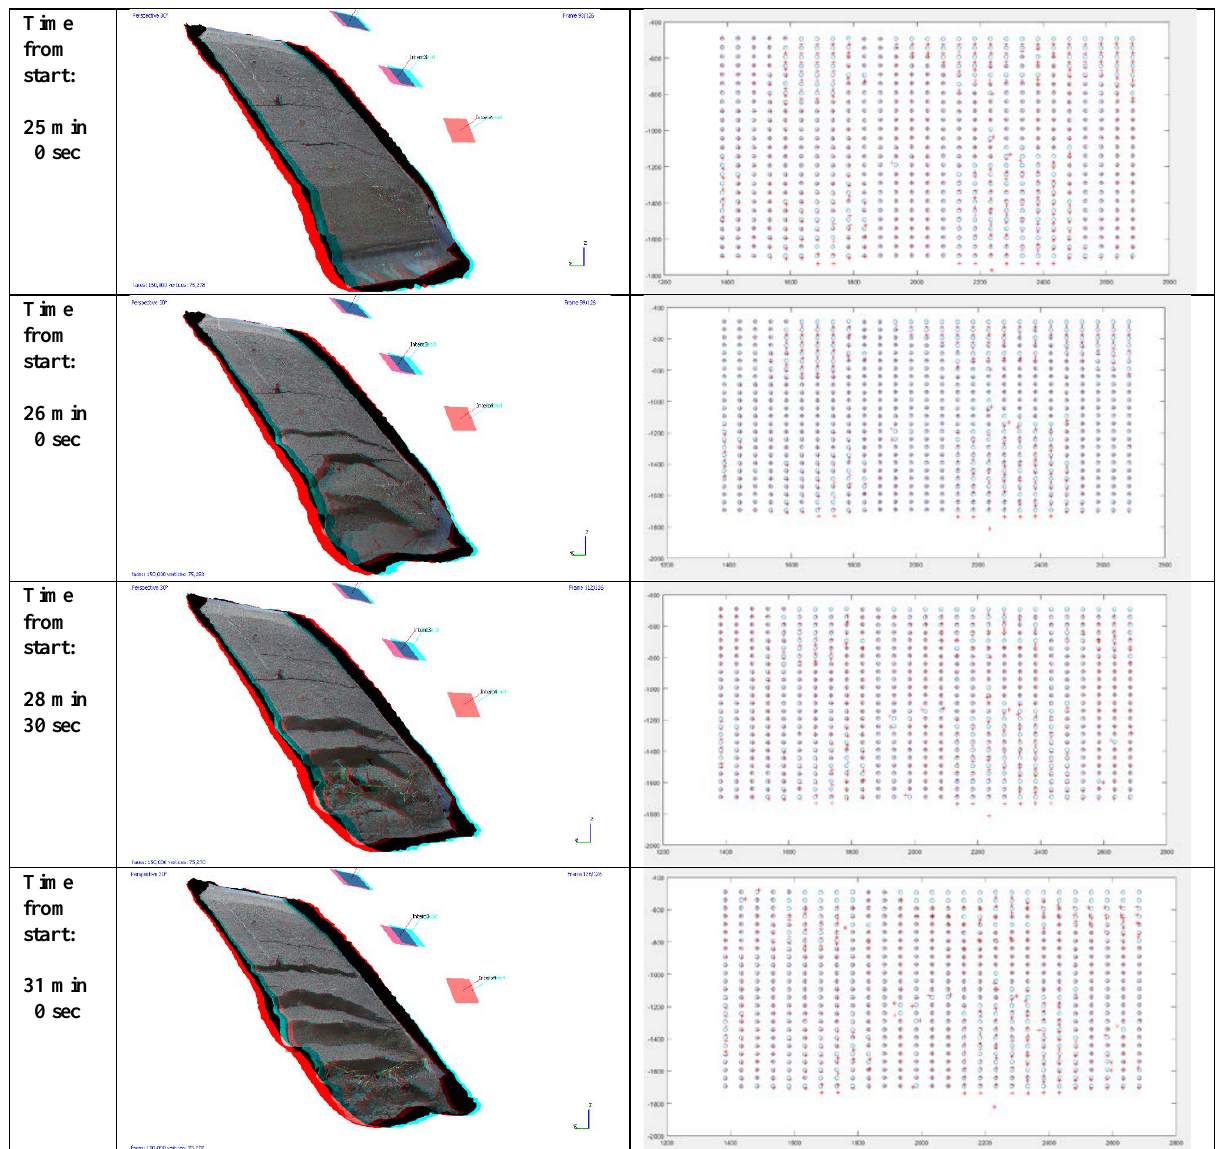
Figure 4. On the left column, 3D models corresponding to relevant events during landslide simulation are depicted in anaglyph representation for 3D stereovision with coloured glasses. On the right column, corresponding point displacements obtained from DIC analysis are shown: blue circles represent positions of initial surface points to track, while red crosses give the shifted position of points at the same time of the contemporary 3D model.